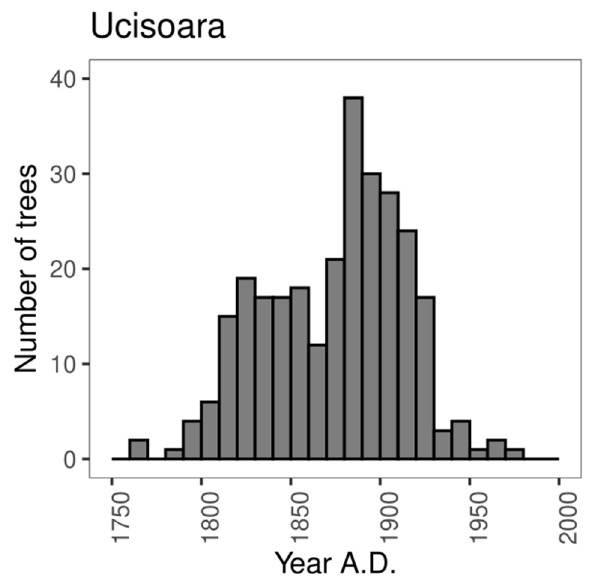
Figure 4. Tree establishment distribution.